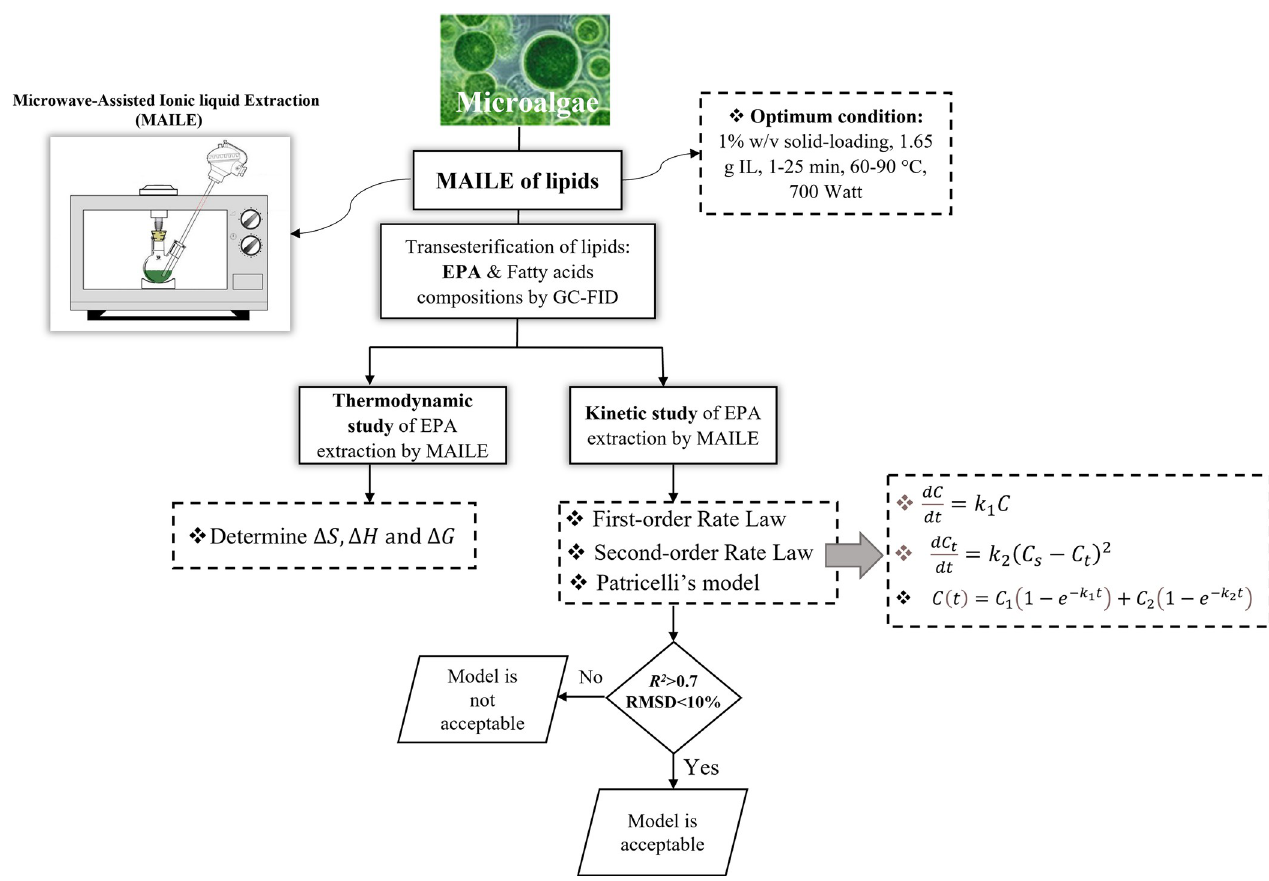
Fig 2. The stepwise development of study